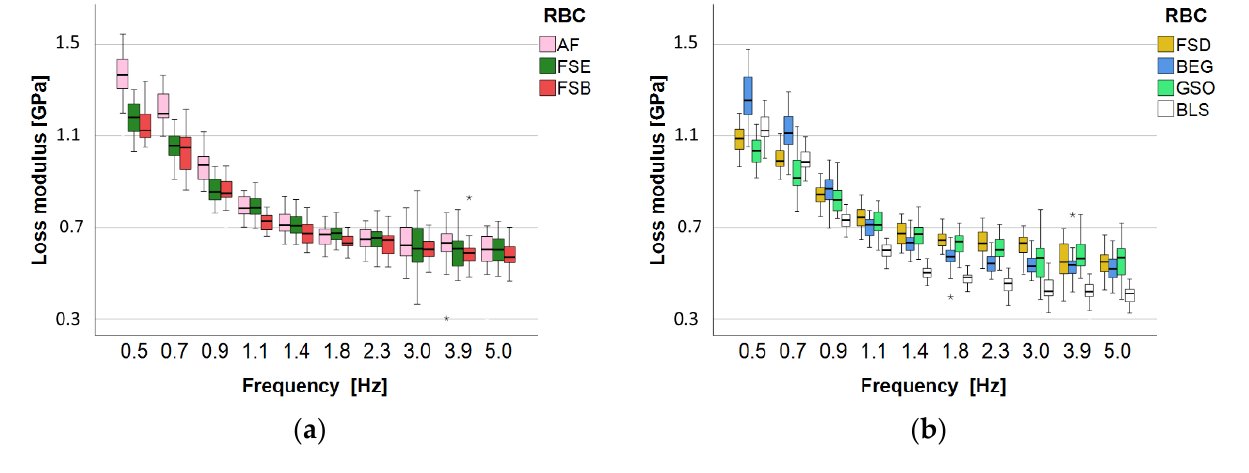
Figure 12. Dynamic mechanical analysis: loss modulus as a function of material and frequency for ( a ) AF, FSE, and FSB, and ( b ) FSD, BEG, GSO, and BLS. Material abbreviation: AF = Admira Fusion; BEG = Brilliant EverGlow; BLS = Beautifil II LS; FSB = Filtek Supreme XTE Body; FSD = Filtek Supreme XTE Dentin; FSE = Filtek Supreme XTE Enamel; GSO = Grandio SO (asterisks indicate outliers).